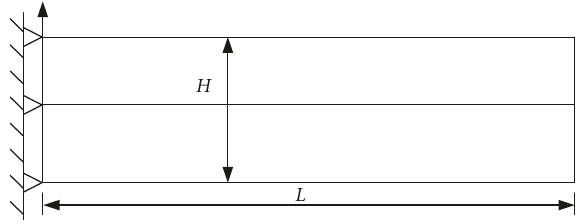
Figure 13: Cantilever beam problem.